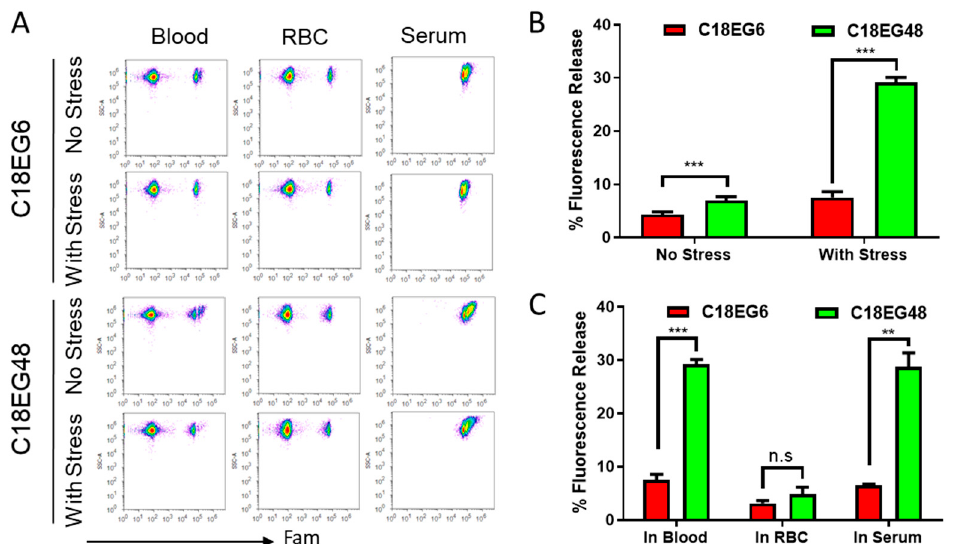
Figure 2. Shear stress-induced release of lipo-PEGs on RBC surface. C18-PEGs-loaded RBCs were mixed with whole blood, or unloaded RBCs, or serum, and shear stress was applied for 15 min. Cells were assayed by flow cytometer. Flow dot plot ( A ) and percentage of release ( B , C ) of lipo-PEGs from RBCs w/wo shear stress. Plot ( B ) shows the percentage of fluorescence release of lipo-PEGs in blood with or without shear stress. Plot ( C ) shows the fluorescence release after 15 min shearing at 10 Pa from lipo ‐ PEGs loaded RBCs in each of the suspension media. Each sample was assayed with three replicates. Error bars represent the SEM. Data show the mean values ± SEM. *, p < 0.05; **, p < 0.01; ***, p < 0.001; ****, p < 0.0001; ns, not significant.